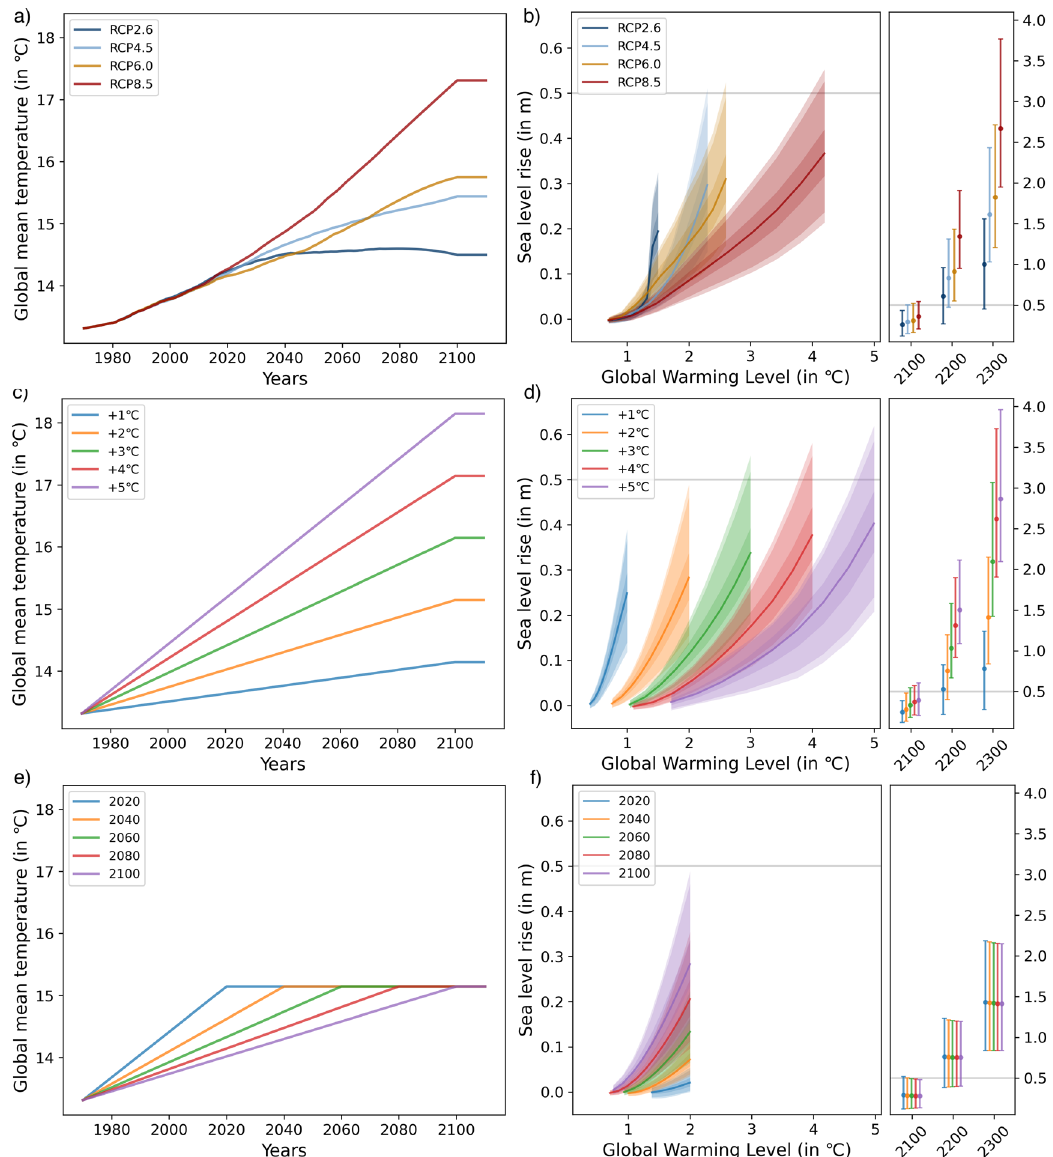
Fig. 7 Projected AIS sea-level contribution per GWL. a Smoothed global mean surface air temperature of the RCP scenarios, which is the forcing for the statistical emulator (details about the smoothing can be found in the Methods). b Left: sea-level rise per °C global warming relative to 2000 for each RCP scenario up to 2100. Right: range of emulated AIS sea-level rise contribution at 2100, 2200, and 2300 relative to 2000 for each RCP scenario. The different shadings indicate the 50, 90, and 95% percentile ranges of the historically constrained emulator runs. The circles indicate the median contribution of a given scenario and the gray bar shows the difference in y -axis scales. c , d Same as a and b , but for idealized experiments of 1, 2, 3, 4, and 5 °C global warming by 2100. e Idealized experiments altering the rate at which 2 °C warming is reached. f Left: sea-level rise per °C global warming relative to 2000 for each warming rate scenario up to the time at which 2 °C is reached. Right: range of emulated AIS sea-level rise contribution at 2100, 2200, and 2300 relative to 2000 for each warming rate